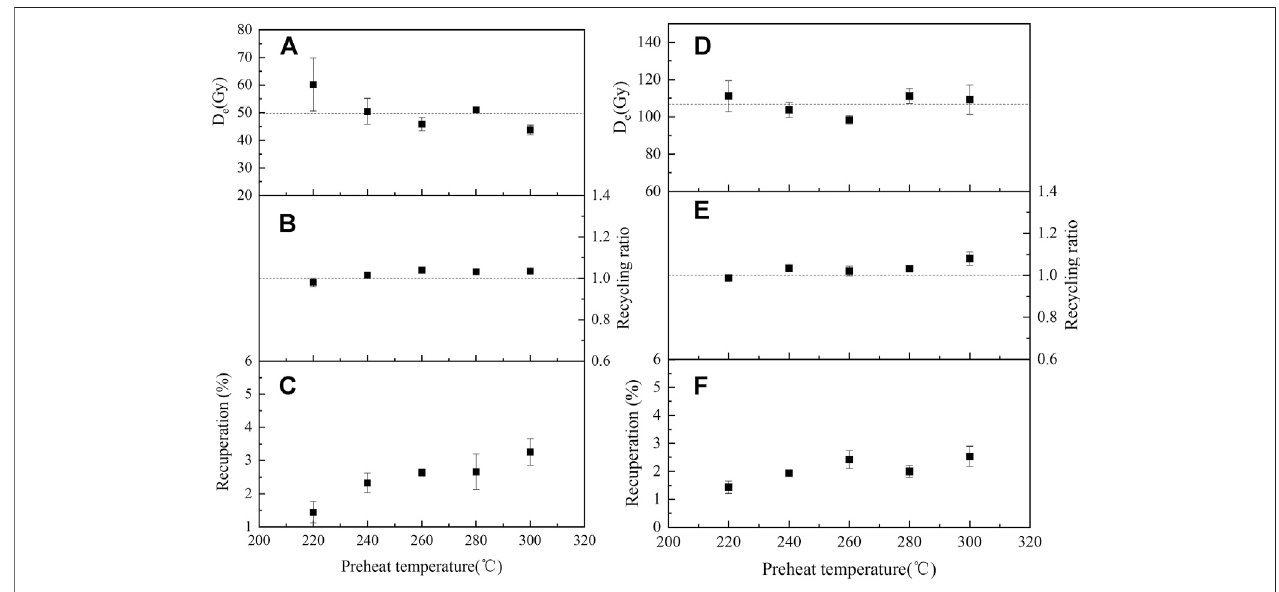
FIGURE 4 | Results of preheat plateau tests (A) and (D) , recuperation (C) and (F) , and recycling ratio (B) and (E) for ALK4-3 (left) and RYS3-2 (right) . The equivalent dose ( D e ) of each data point is the mean of four aliquots. The fi nal chosen preheat temperature for quartz OSL dating in this study was 260 ° C.